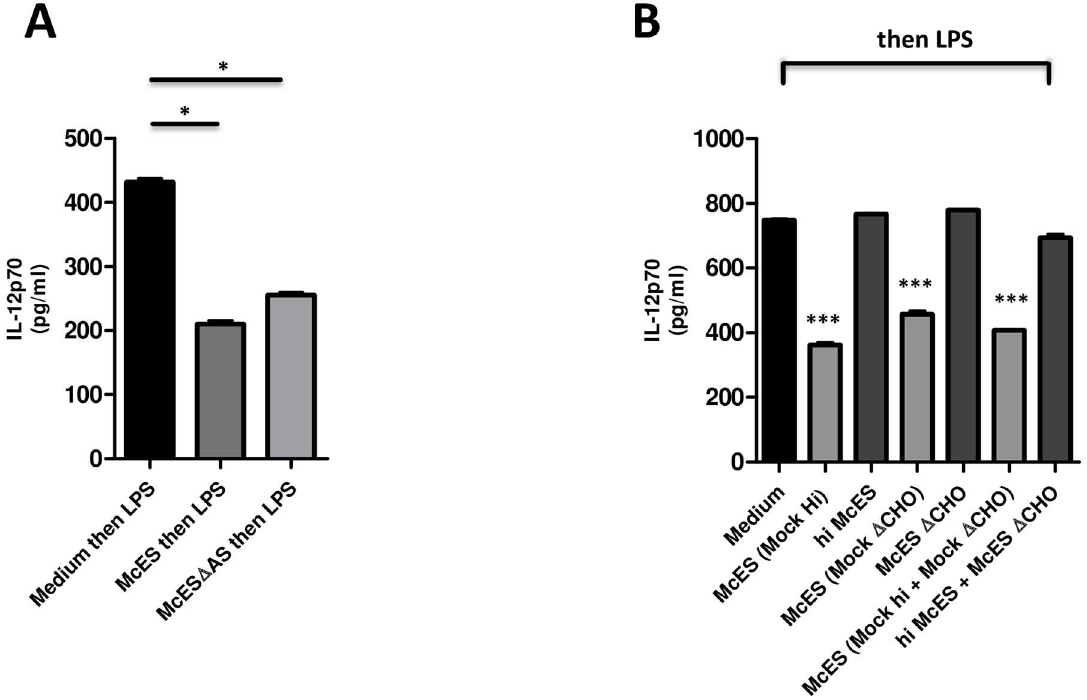
Fig 4. The BMDC-suppressive principle within McES is a glycoprotein. BMDCs were generated in vitro from C57BL/6 mice bone marrow cells and stimulated in vitro with 5 μ g/ml of M . corti ES products (McES) for 24 h before restimulation